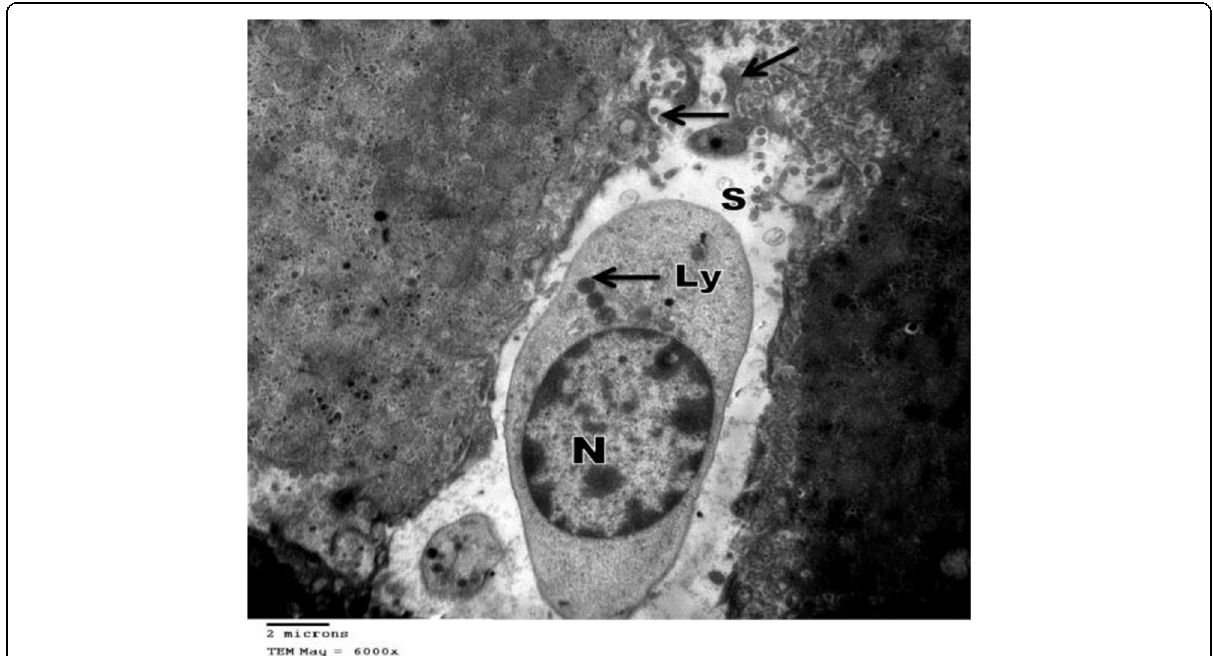
Fig. 15 An electron micrograph of a Kupffer cell of treated mouse with Tamiflu (16 mg/kg b.wt.) for 5 days showing lysosomes (Ly), nucleus (N), dilatation of sinusoid (S), and microvilli (arrows). (× 6000)